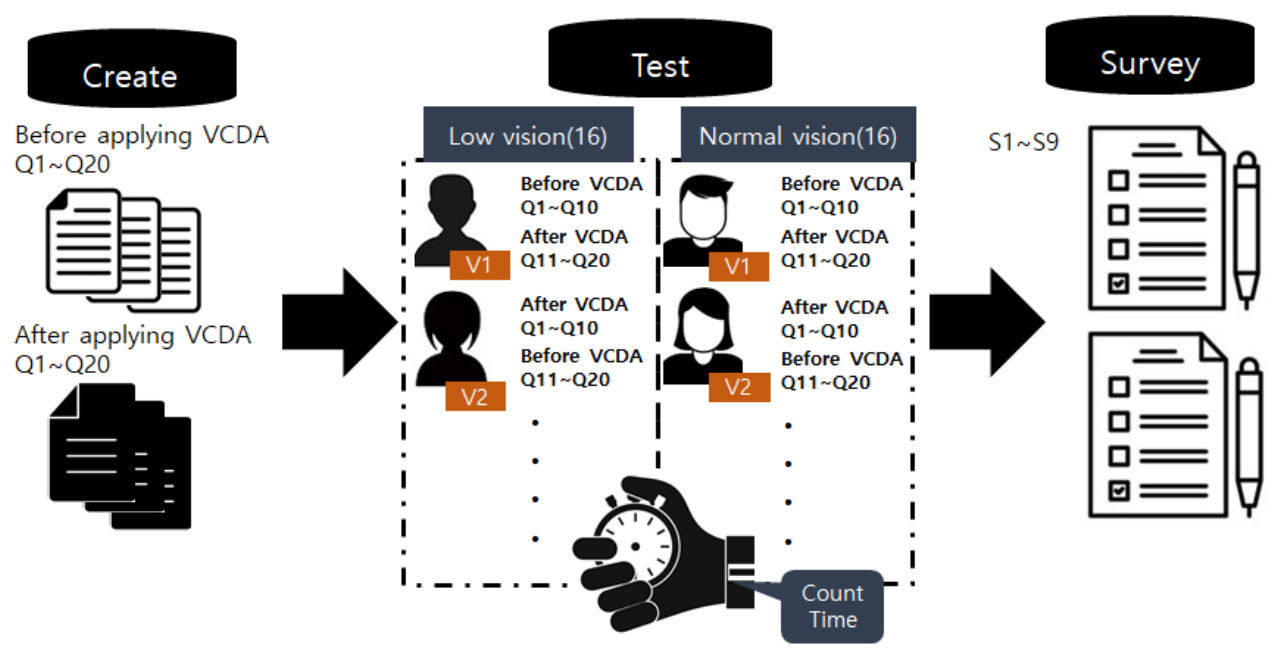
Figure 2. Information recognition speed test procedure.